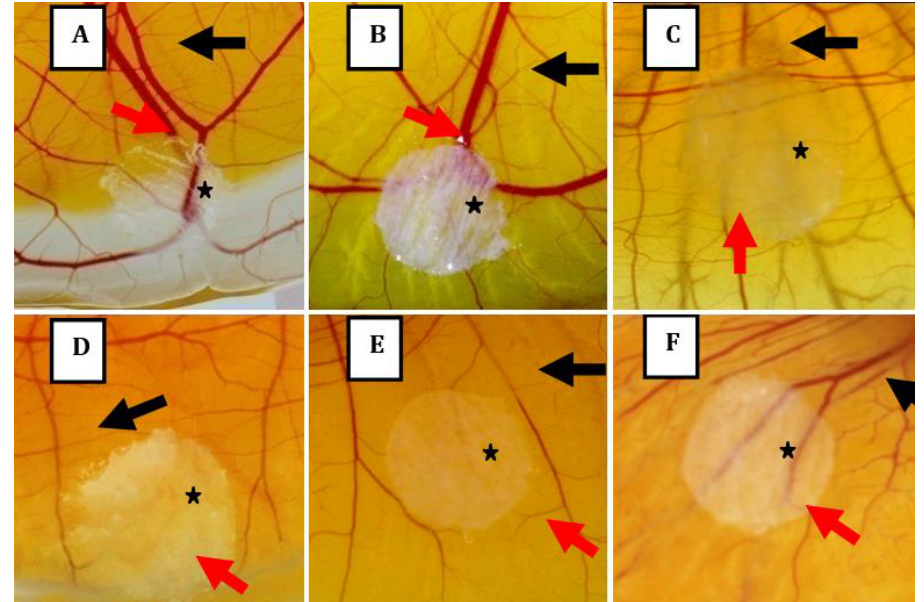
Figure 3. The images of living CAMs implanted from ventral side at 8th days old. A: Paper disc + bFGF 30 ng/mL as a negative control; B: paper disc + bFGF 30 ng/mL + Tylophorine 9.2 µM/mL as positive control; C: paper disc + bFGF 30 ng/mL + extract 13.00 mg/ml; D: paper disc + bFGF 30 ng/mL + extract 9.75 mg/ml; E: paper disc + bFGF 30 ng/mL + extract 6.50 mg/ml; F: paper disc + bFGF 30 ng/mL + extract 3.25 mg/ml; these images show the effect of awar-awar leaves extract on bFGF-induced angiogenesis in CAM. Star: implant paper disc; black arrows: main blood vessel, red arrows: new blood vessel.